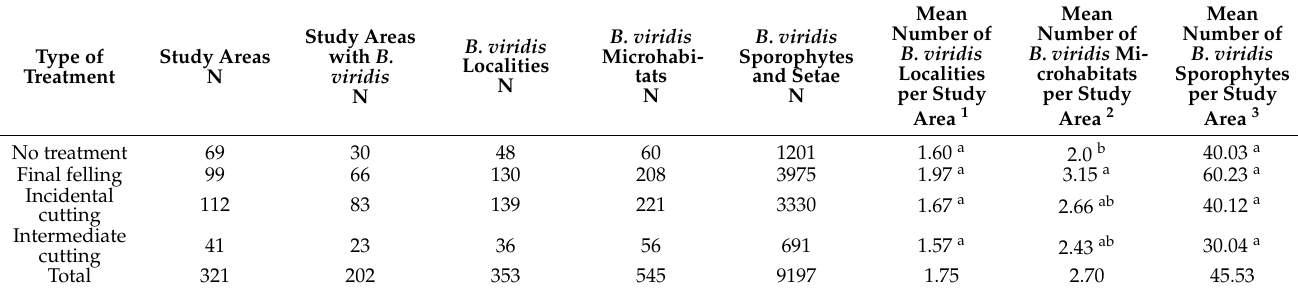
Table 2. Occurrence of Buxbaumia viridis depending on silvicultural treatment.